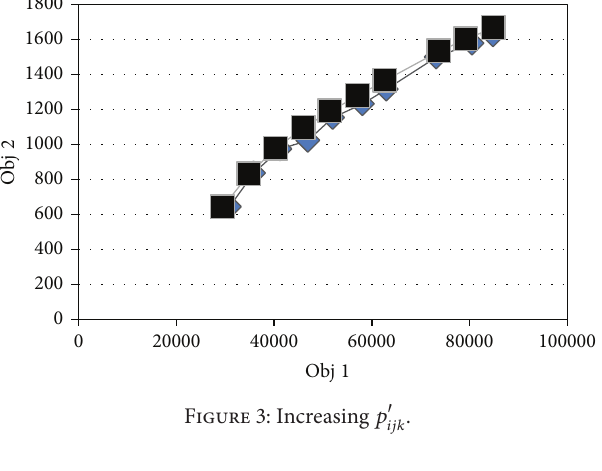
Figure 3: Increasing 𝑝 󸀠 𝑖𝑗𝑘 .